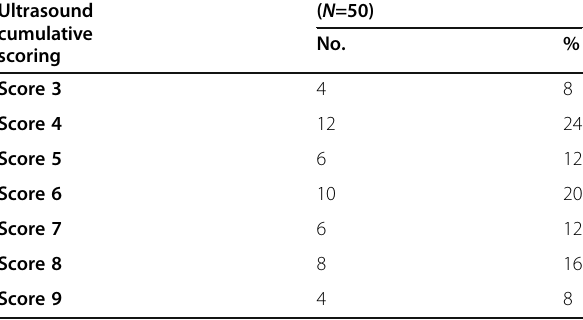
Table 1 US scoring of liver fibrosis among the studied cases Ultrasound cumulative